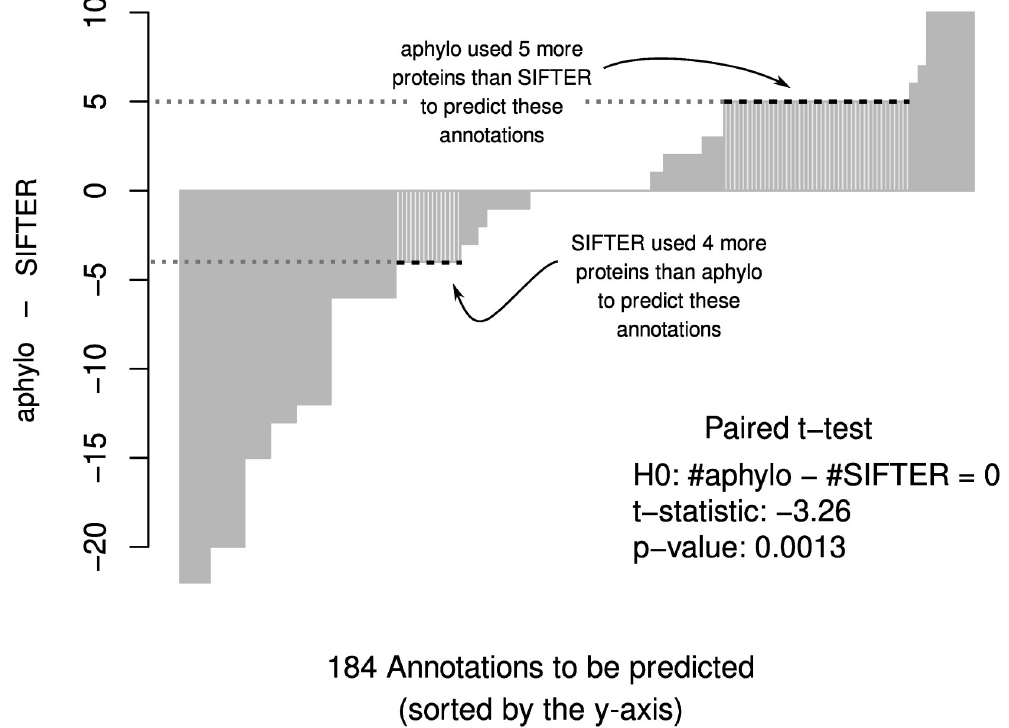
Fig 13. Difference in the number of input proteins used for predictions. Each bar represents a single annotation (prediction) to be made. The y-axis shows the difference between the number of input proteins used by aphylo, and SIFTER. Negative values indicate that SIFTER included more proteins as input for making the prediction, whereas positive values indicate that aphylo included more proteins as input. A paired t-test shows that, on average, SIFTER included more proteins than aphylo for each one of its